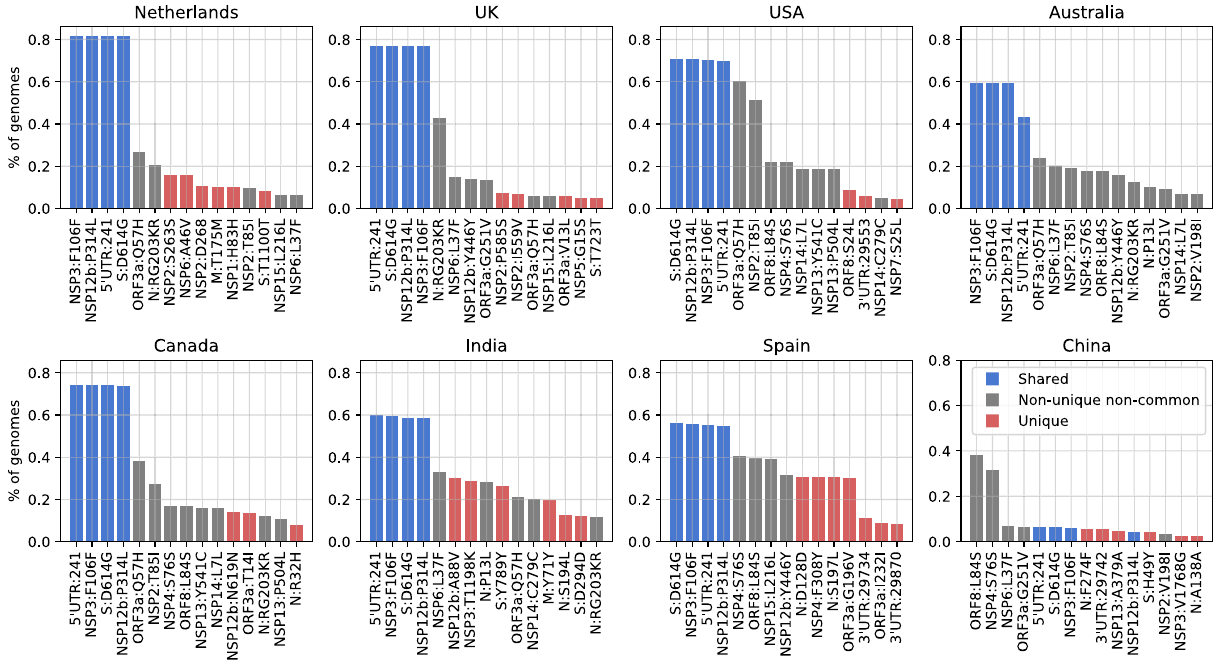
mutations. Blue bars are mutations shared across all these countries in the top 15, while the red bars are unique to that one country in the top 15 and the gray bars are non-unique and non-common variants where the mutation is observed in more than one